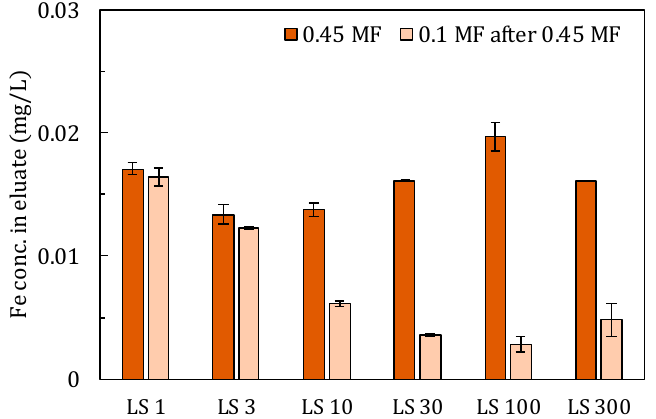
Figure 4. Concentration of Fe in filtrate using 0.45 µ m membrane filter (MF) and in filtrate after re-filtration of 0.45 µ m filtrate using the 0.1 µ m membrane.